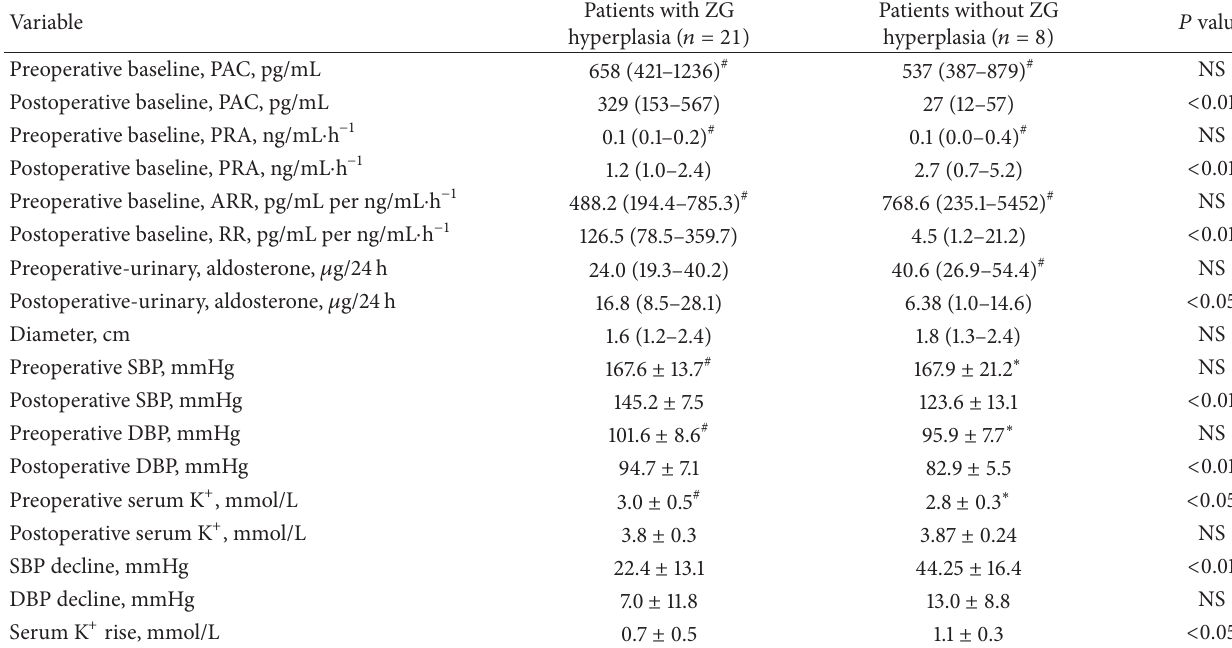
Figure 2: Pathological and immunohistochemical findings of Nox2 in normal adrenocortical tissue, APA, and NFA. (a, d, g, j, and m) HES staining of normal adrenocortical tissue (a), APA (d and g), and NFA (j and m). (b and c) Nox2 and Dab2 were expressed in normal adrenocortical ZG cells. However, Nox2 was also restricted to the ZR. (d–o) Nox2 and Dab2 expression were detectable and visible beneath the capsule (h, i, k, and l) and along the vasculature (e, f, n, and o) in APA and NFA as indicated by HES. Moreover, higher magnification revealed predominant cytoplasmic localization of Nox2 and Dab2. (p) Graphical illustration of statistical distributions of Nox2 in normal adrenocortical tissue, APA, and NFA. The Nox2 IRS (immunoreactive score) was higher in APA compared to those in normal adrenal tissue and NFA. Bar, 200 𝜇 m on low magnification (100x) and 50 𝜇 m on high magnification (400x). Table 2: Clinical and biological data of patients with or without ZG